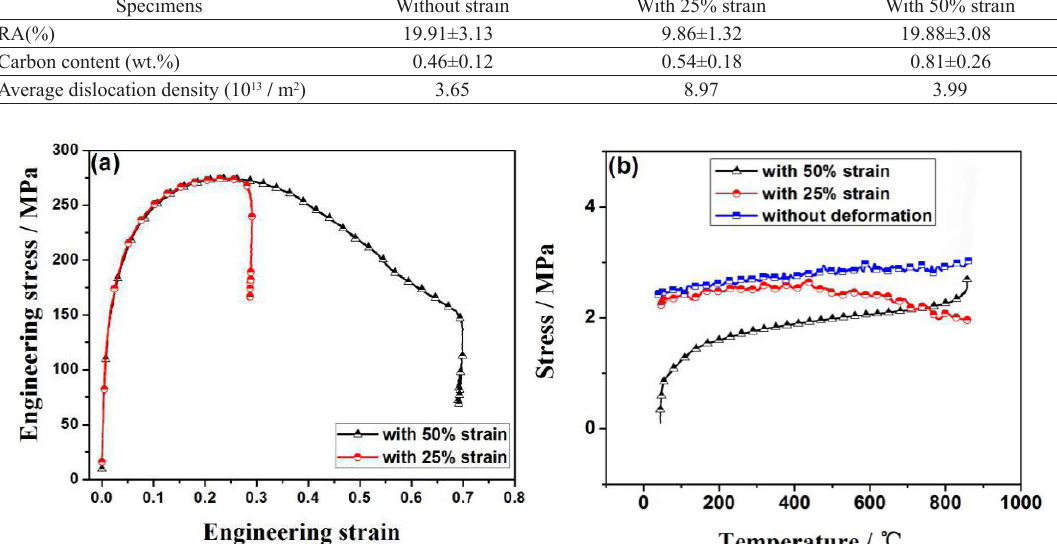
Figure 6. (a) Stress-strain curves with different strains during deformation; (b) stress state during cooling period versus temperature